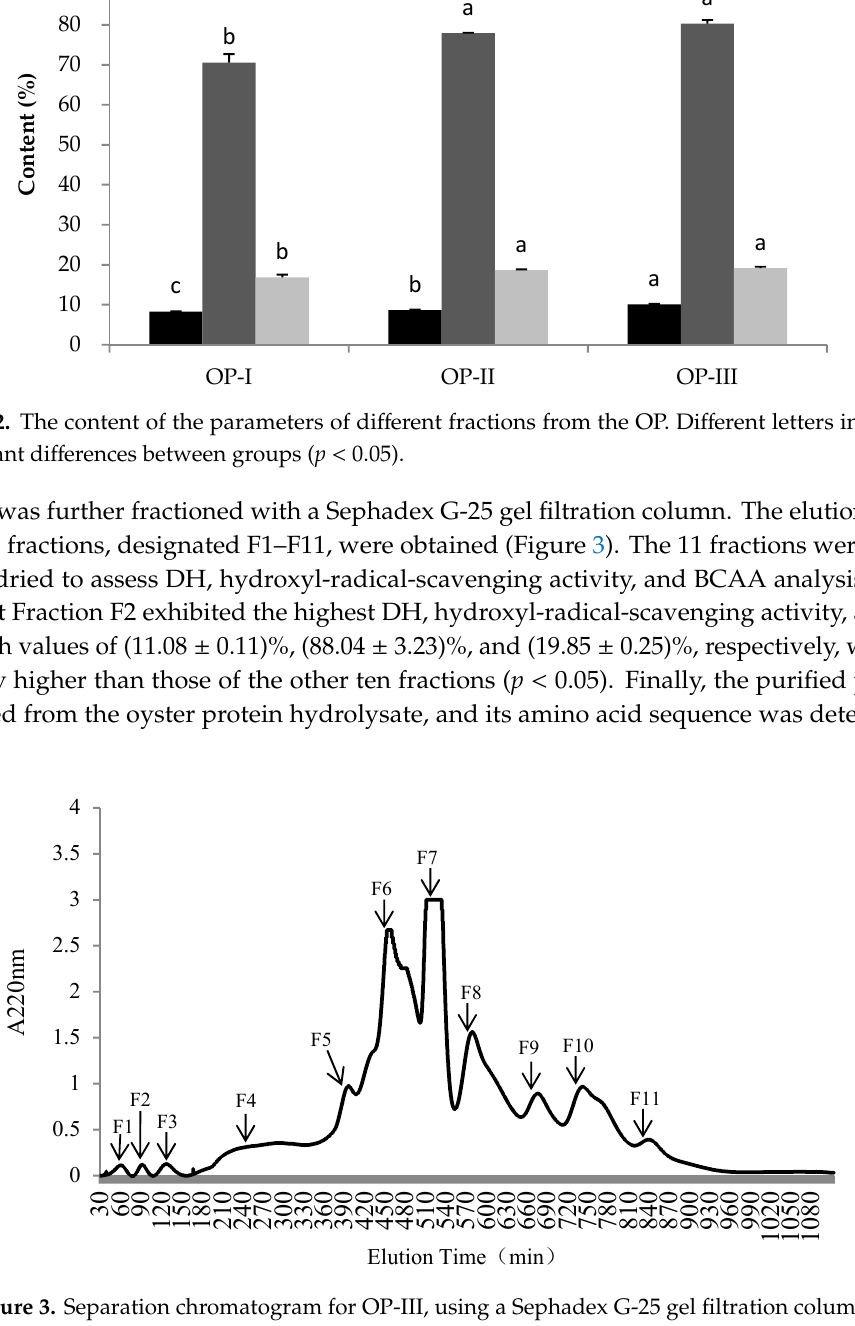
Figure 3. Separation chromatogram for OP-III, using a Sephadex G-25 gel filtration column.